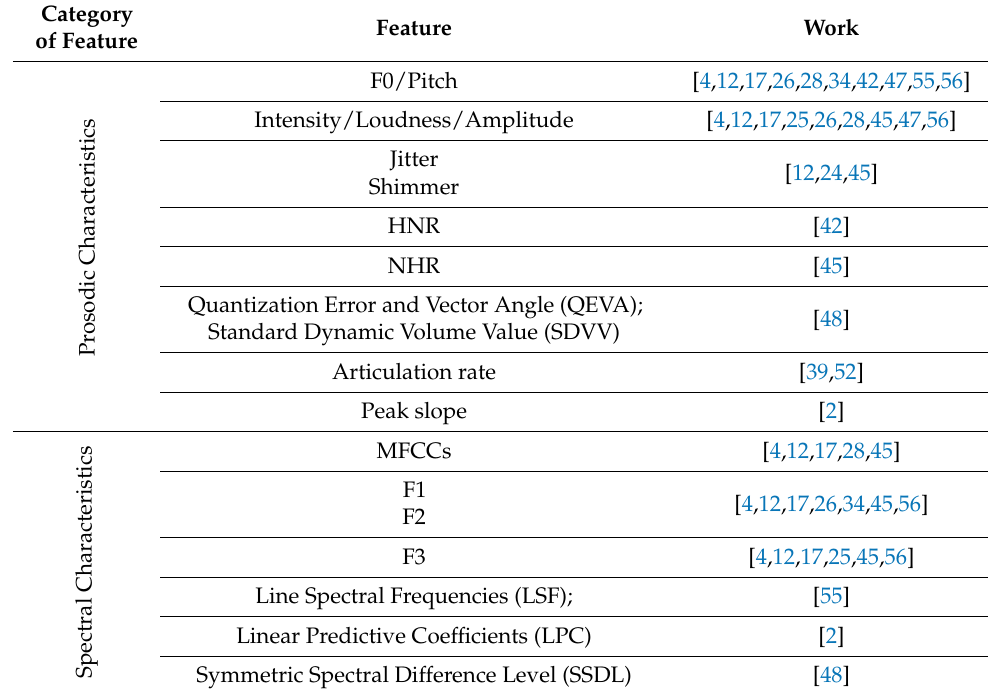
Table 1. Speech features used to identify